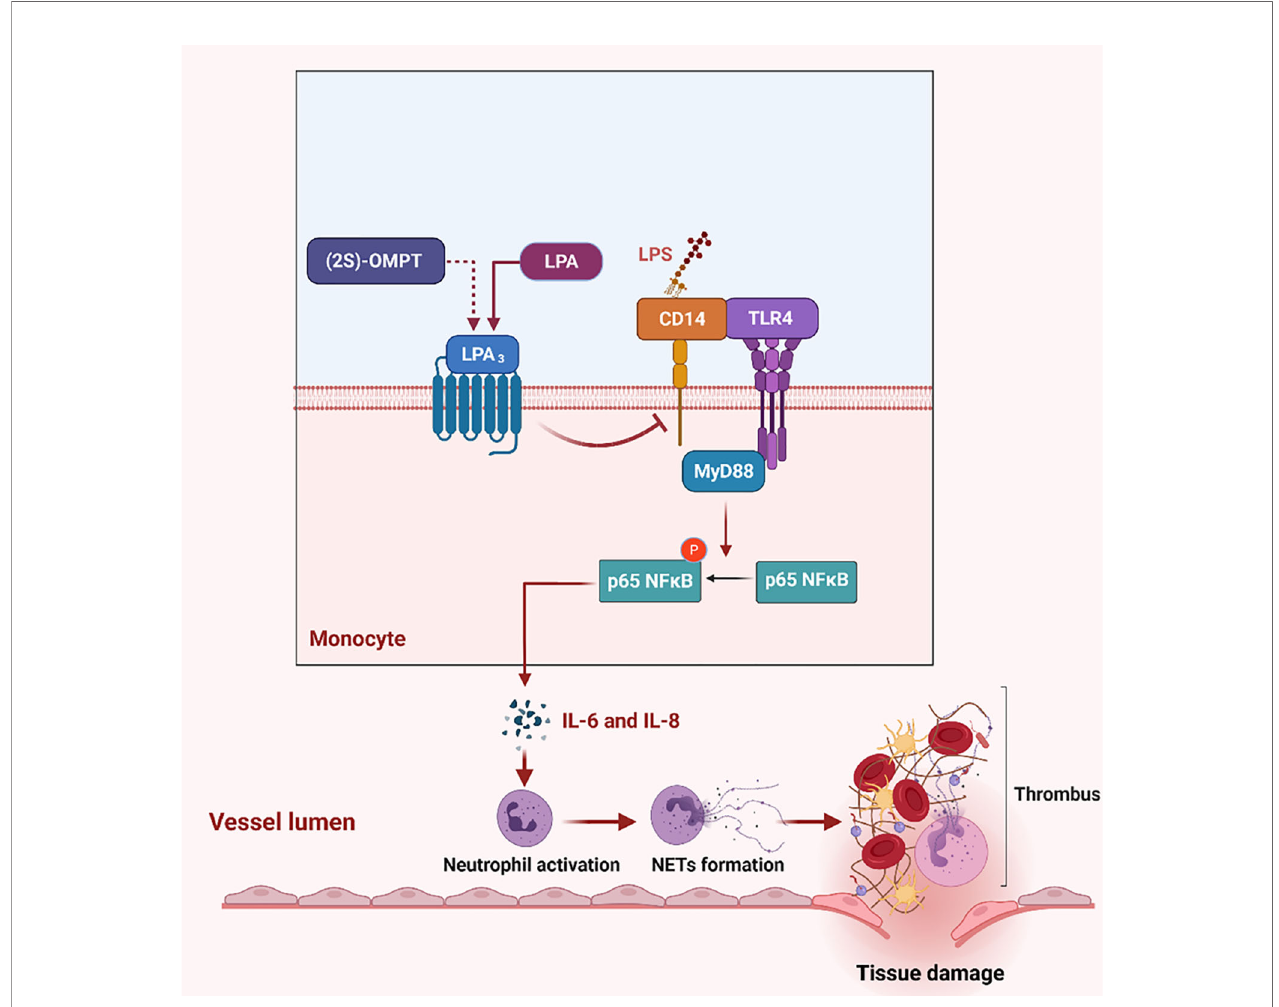
FIGURE 8 | The role of LPA 3 protects against the organism by affecting the TLR4 signaling pathway and NETs release. During sepsis, LPA 3 de fi ciency monocytes are stimulated to express more quantities of CD14, which interacts with LPS and activates TLR4 signaling pathway. Activation of the TLR4-MyD88-p65 NF k B signaling pathway controls in fl ammatory cytokines (IL-6 and IL-8) release, induces excessive NETs, further causes thrombosis and tissue damage. (2S)-OMPT, the agonist of LPA 3 , inhibits the in fl ammatory cytokines and NETs formation, reduces tissue damage and septic lethality, to be a therapeutic improvement in sepsis treatment. Illustration created with BioRender. Abbreviations: LPA 3 , lysophosphatidic acid receptor 3; NETs, neutrophil extracellular traps; LPS, lipopolysaccharide; TLR4, Toll-like receptor 4. (2S)-OMPT;